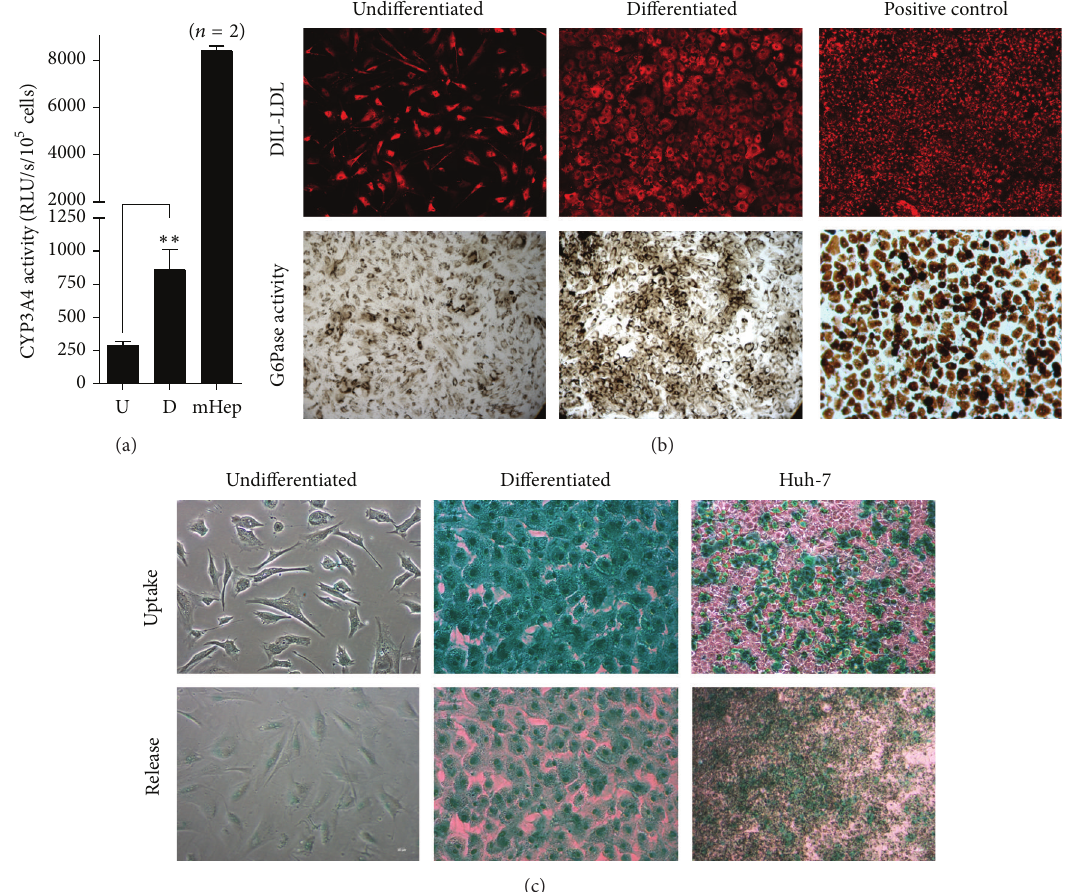
Figure 5: In vitro functional hepatocytic differentiation of FL-MSCs. (a) Undifferentiated and differentiated FL-MSCs were incubated with IPA substrate for 4 hours and luciferase activity was measured. Results are expressed as the relative luminescence unit detected in the differentiated (D) cells versus undifferentiated (U) counterparts. Data shown are the mean ± SEM of at least 4 independent experiments. Freshly isolated mouse hepatocytes ( 𝑛 = 2 ), tested under the same experimental conditions for evaluation of CYP3A4 activity, were used as positive controls. (b) Dil-LDL uptake analysis was evaluated after 3h incubation. Fixed cells were checked using fluorescent microscope. Huh-7 cells were used as a positive control. Pictures were taken at magnification of 200x. The activity of glucose 6-phosphatase (G6Pase) was assessed using cytochemistry. Brown stained cells revealed their ability to convert glucose-6-phosphate substrate to glucose by active G6-Pase. Freshly isolated human hepatocytes were used as a positive control. If both cell groups were displaying Dil-LDL uptake and G6-Pase activity, differentiated FL-MSCs showed more consistent functionalities. All images are representative of 3 different experiments. Magnification: 200x. (c)Indocyaninegreenuptakeandrelease.Huh-7cellswereusedasapositivecontrol.Datashownarerepresentativeof4differentexperiments. Magnification: